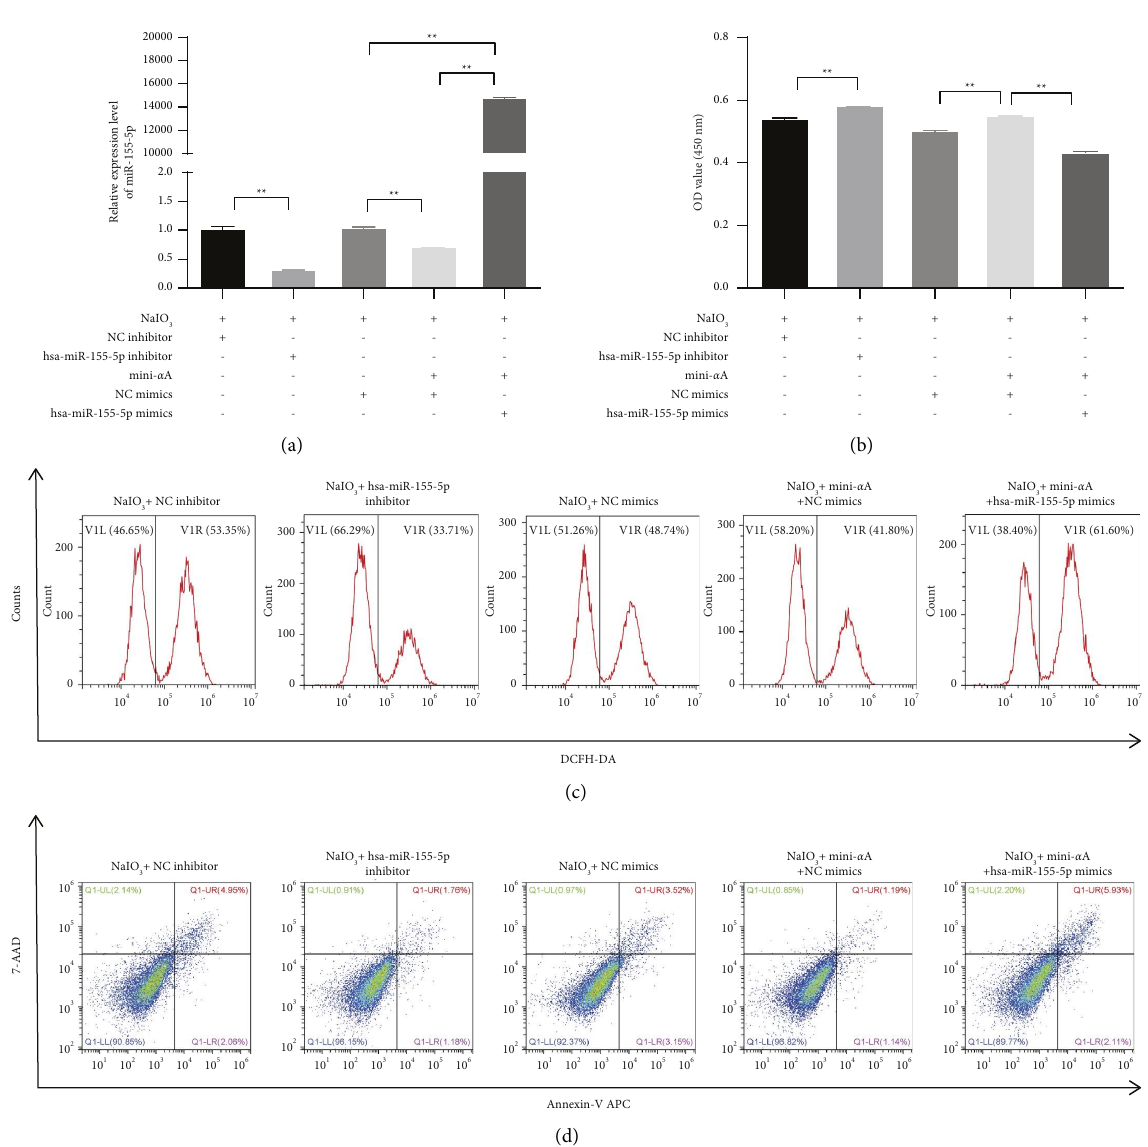
Figure 3: miR-155-5p participates in the therapeutic efect of mini- α A on oxidative damage. ARPE-19 cells were treated with NaIO following which interference and overexpression of miR-155-5p were performed. (a) Interference and overexpression efciency of miR-155- 5p was confrmed by qRT-PCR. (b) Cell viability was determined by CCK-8. (c) ROS level was assessed by reactive oxygen species assay kit. (d) Apoptosis was detected using annexin V/7-AAD double staining. ∗ P < 0 . 05 and ∗∗ P < 0 .